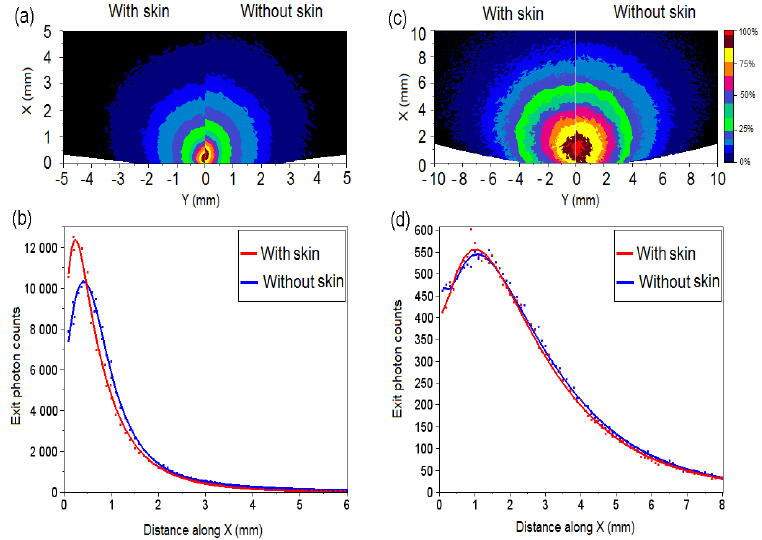
Figure 7. Simulated backscattering images ( a) - (c ) captured over the equatorial plane of half-cut apple models with and without skin, and corresponding diffuse reflectance profiles ( b) - (d ), plotted along X for Y = 0 and Z = 0. ( a) - (b ) Source located at z = −0.5 mm from the plane surface, and ( c) - (d ) source located at z = −3 mm. The data were generated with µ a ( f ) = 0.0075 mm −1 - µ ’ s ( f ) = 1.25 mm −1 , µ a ( s ) = 0.05